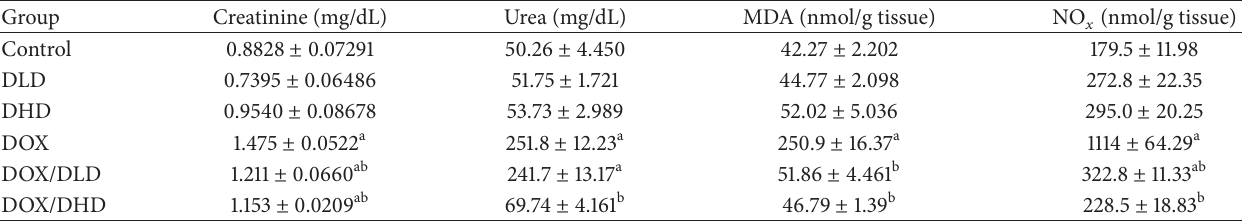
Table 1: Effect of DLD (25mg/kg/day) and DHD (50mg/kg/day) on serum creatinine, serum urea, MDA, and NO 𝑥 levels in DOX -induced nephrotoxicity (15mg/kg).